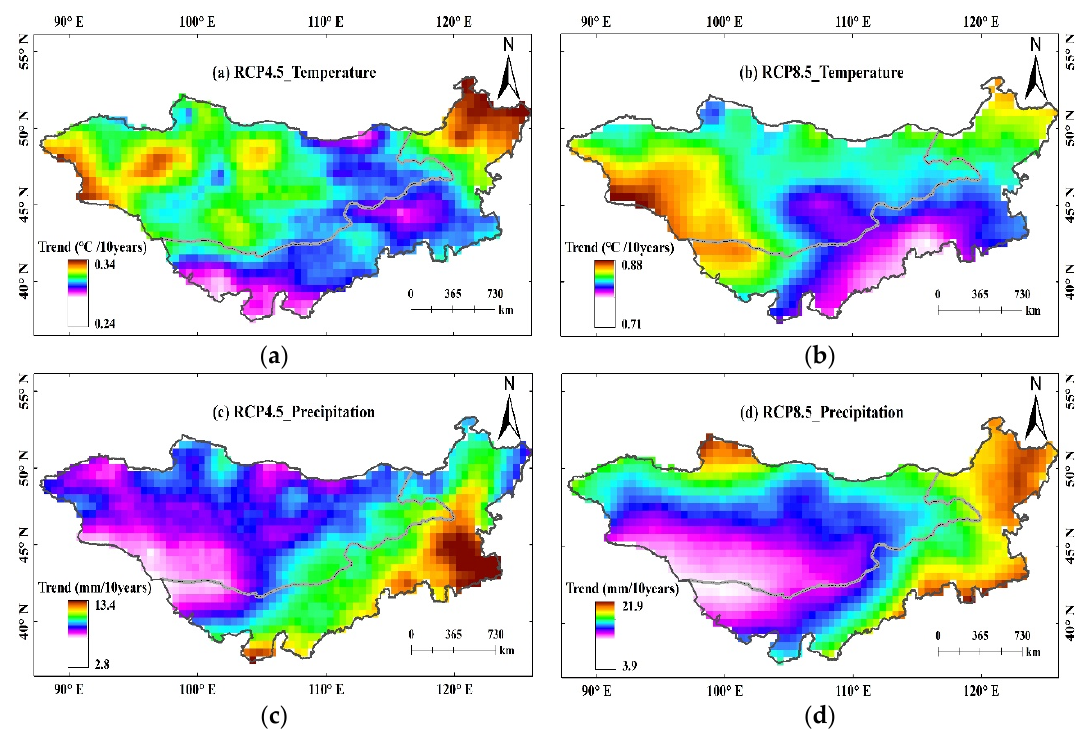
Figure 5. Changes in temperature and precipitation under the ( a , c ) representative concentration pathway RCP4.5 and ( b , d ) RCP8.5 scenarios for the Mongolian Plateau.